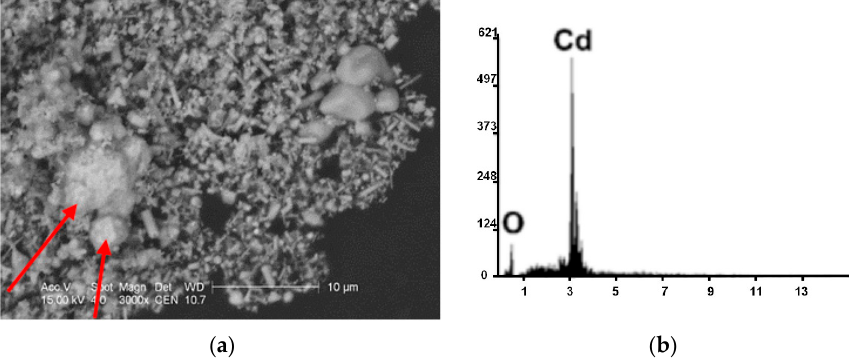
Figure 10. Particles from the zinc rectification process: ( a ) SEM image; the red arrows indicate components with the com- position of cadmium oxides, probably monteponite CdO; ( b ) the XRD spectrum.